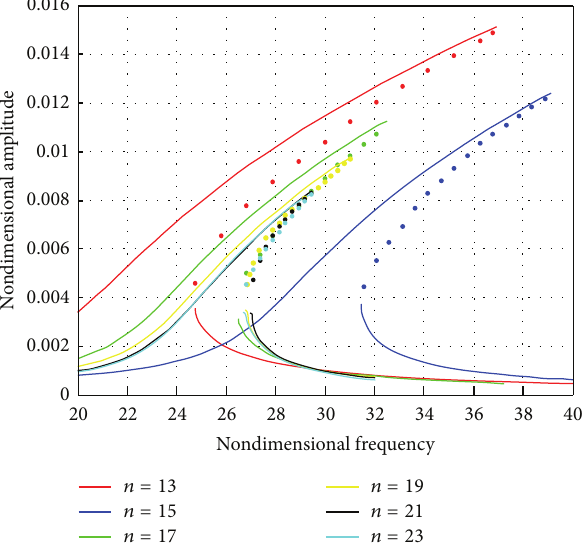
Figure 6: Frequency response convergence of a nonlinear beam 𝛼 = −2